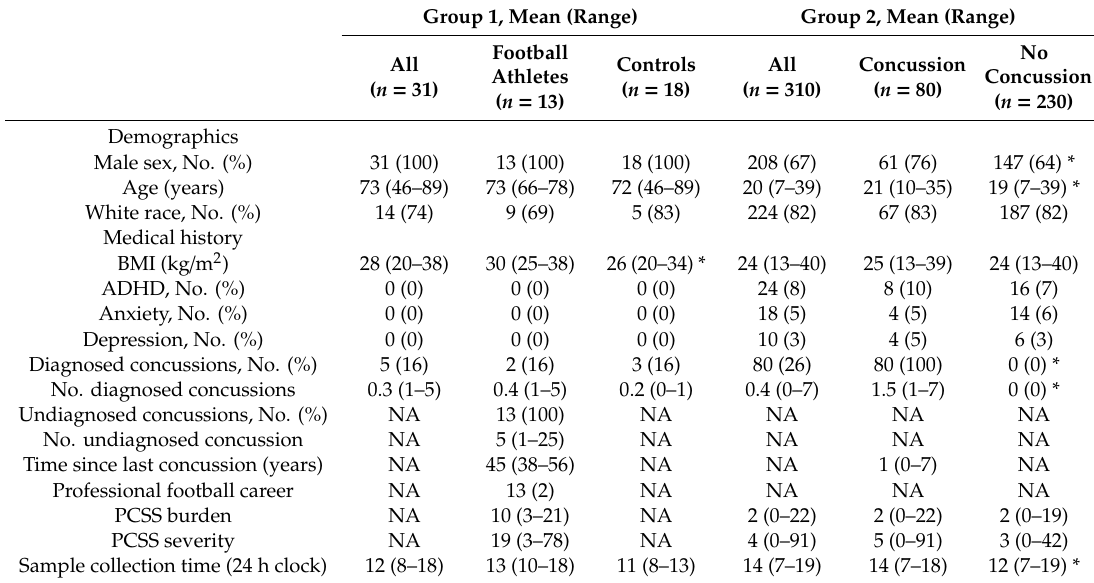
Table 1. Participant characteristics.